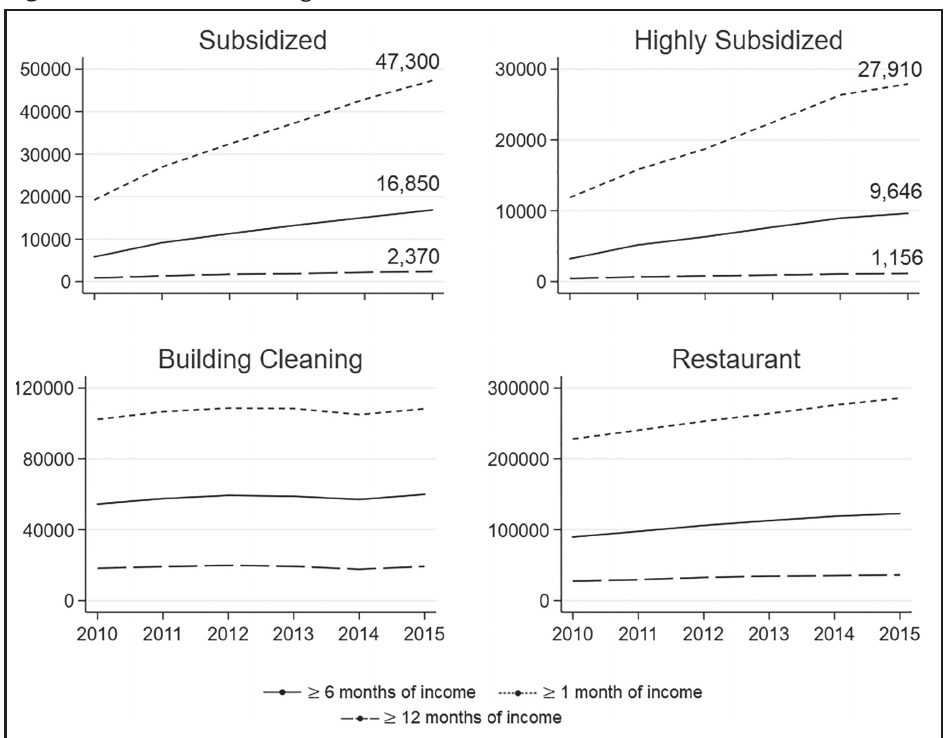
Figure W4 Number of wage